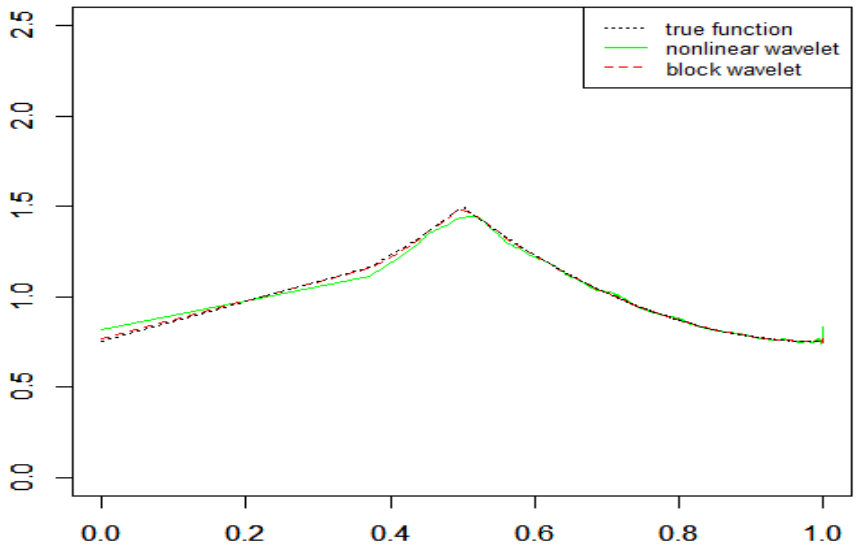
Figure 3. Recovery of the density function for NA samples in the Example 3 ( n =